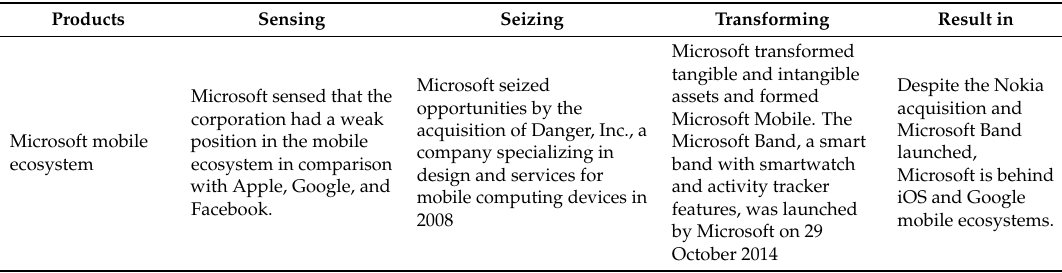
Table 5. Dynamic capabilities at Microsoft to develop mobile ecosystem before the acquisition of Linked In.